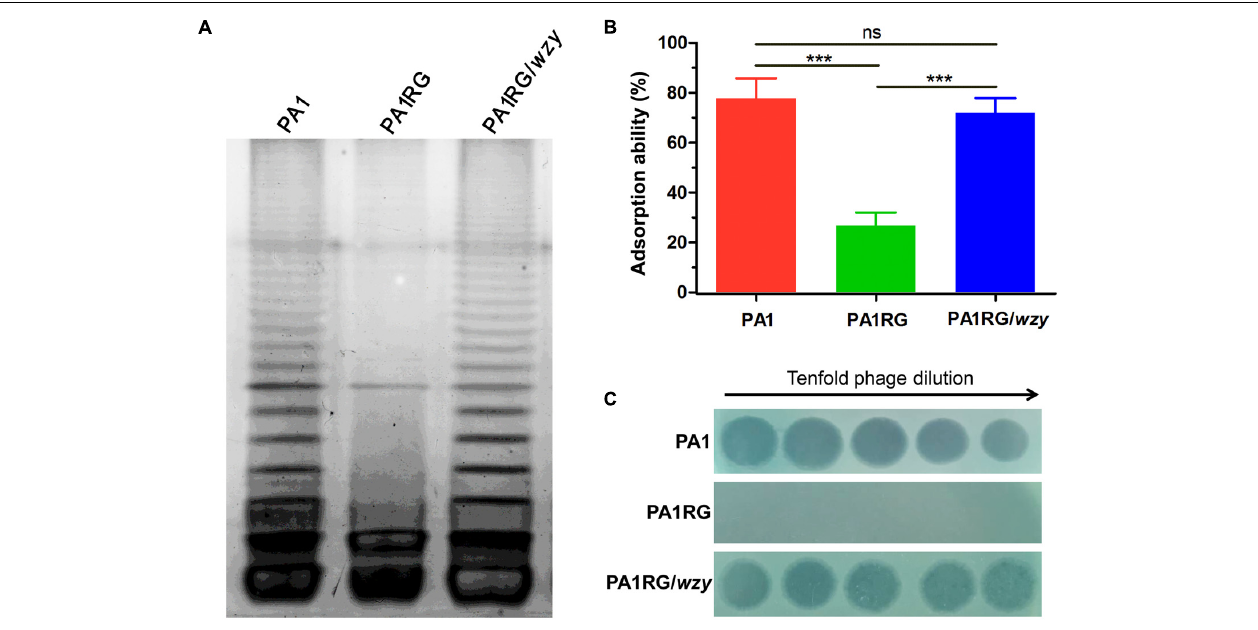
FIGURE 5 | LPS profiling, adsorption assay, and spot assay of PA1RG in comparison with PA1 and PA1RG/ wzy . (A) LPS profiling. Mutant PA1RG produced LPS lacking long chain O -antigen. Complementary strain PA1RG/ wzy displayed the same LPS pattern to that of wild-type PA1. (B) Adsorption assay. Decreased PaP1 attachment was observed for mutant PA1RG, which could be complemented by providing wzy in trans . Data were expressed as mean ± SD from three biological replicates. ns, not significant. ∗∗∗ p < 0.001. (C) Spot assay. Tenfold serial dilutions of PaP1 lysates were applied to the lawns of indicated strains. Phage-resistant PA1RG restored PaP1 susceptibility when bearing the intact gene wzy